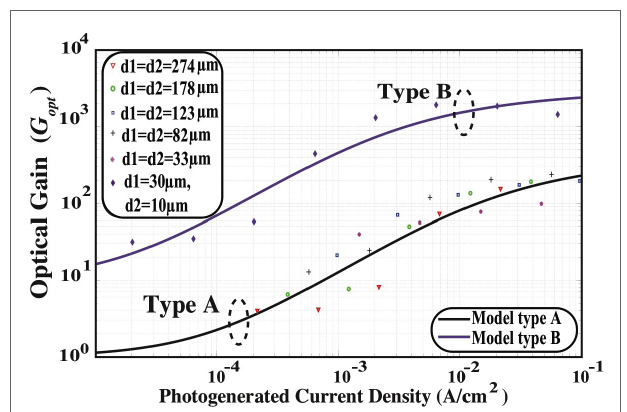
FiGURe 16 | Optical gain as a function of the photogenerated current density at − 3 v bias voltage: markers show the measured data and the solid lines show our developed analytical model . Reproduced with permission from Fathipour et al. (2015). Copyright 2015 AIP Publishing LLC.